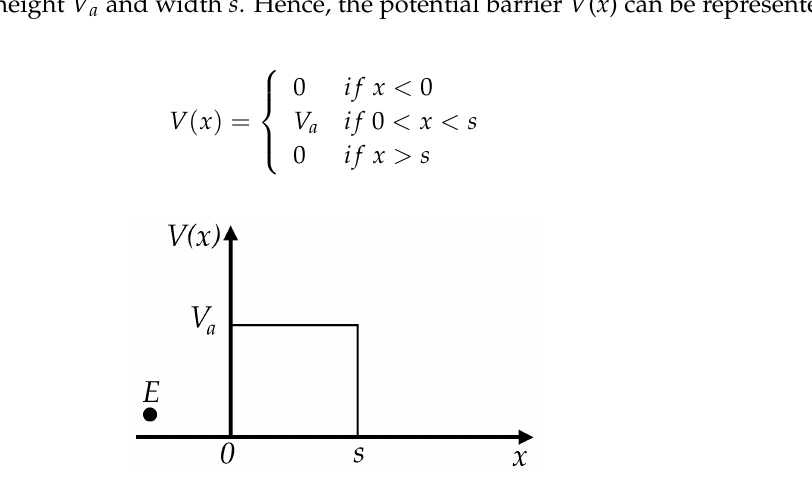
Figure 2. Rectangular potential barrier with height V a and width s next to a particle with energy E .